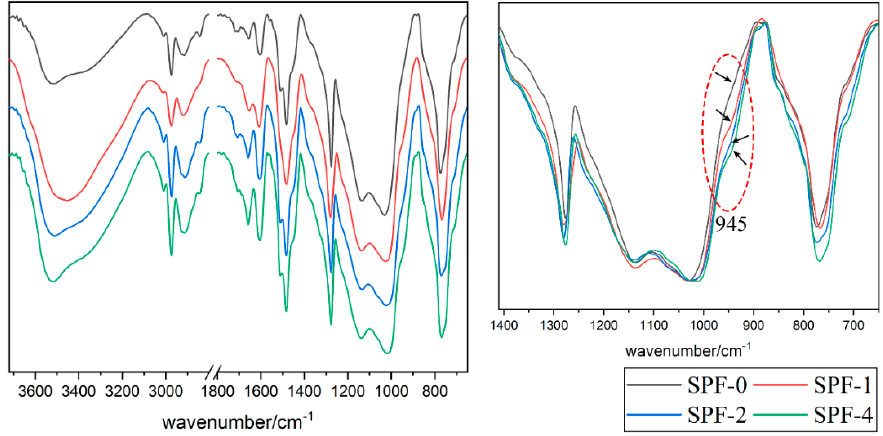
Figure 7. FTIR spectra and partially enlarged spectra of the cured SPF hybrid resins. The signal at 900~1000 cm − 1 was shown on the right to clarify the difference.